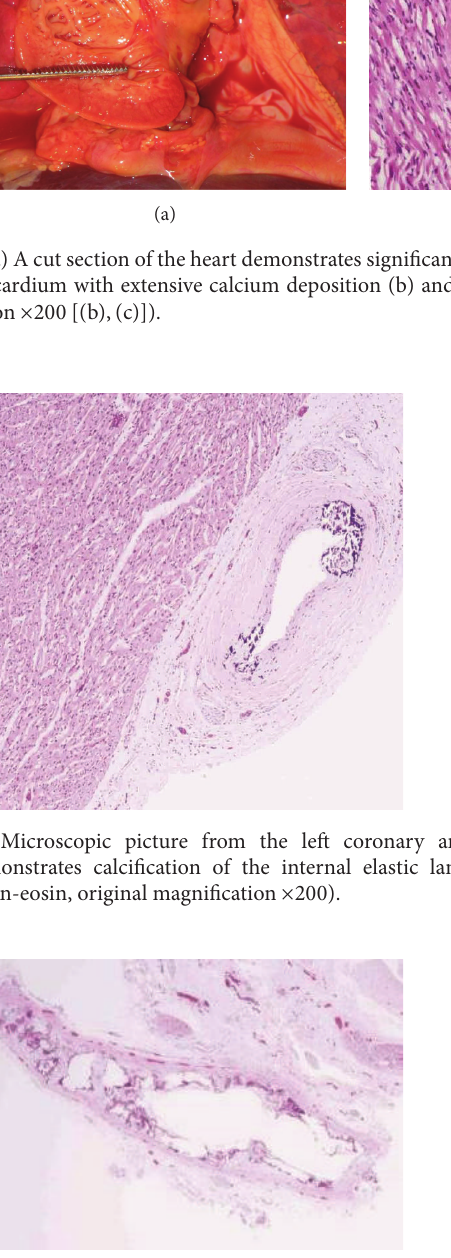
Figure 4: Microscopic picture from the ascending aorta shows extensive calcification with disruption of the elastic lamina and intimal fibrosis (hematoxylin-eosin, original magnification × 200).